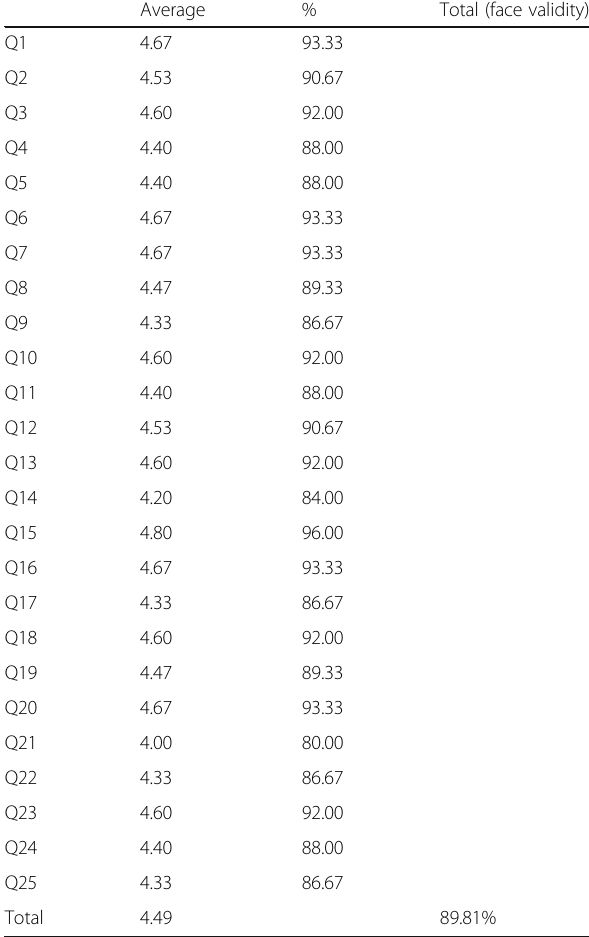
Table 2 Jury score: average and